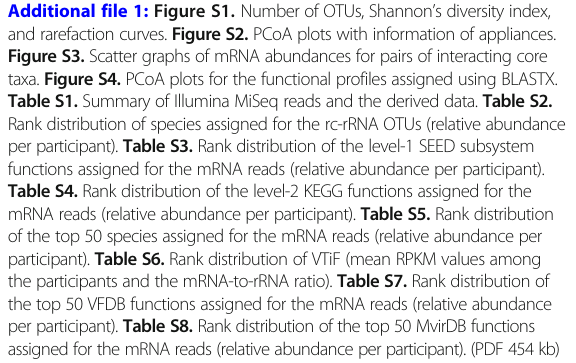
Abbreviations ANOSIM: Analysis of similarity; CLP: Cleft lip and palate; DMFT: Decayed, missing, and filled teeth; GI: Gingival index; HOMD: Human Oral Microbiome Database; KEGG: Kyoto Encyclopedia of Genes and Genomes; MG- RAST: Metagenomics Rapid Annotation using Subsystem Technology; MvirDB: Microbial Virulence Database; NCBI nr: National Center for Biotechnology Information Non-redundant Protein Database; OHI: Oral hygiene index; OTU: Operational taxonomic unit; PCoA: Principal coordinate analysis; rc-rRNA: Reconstructed 16S rRNA; SparCC: Strong, Prosperous